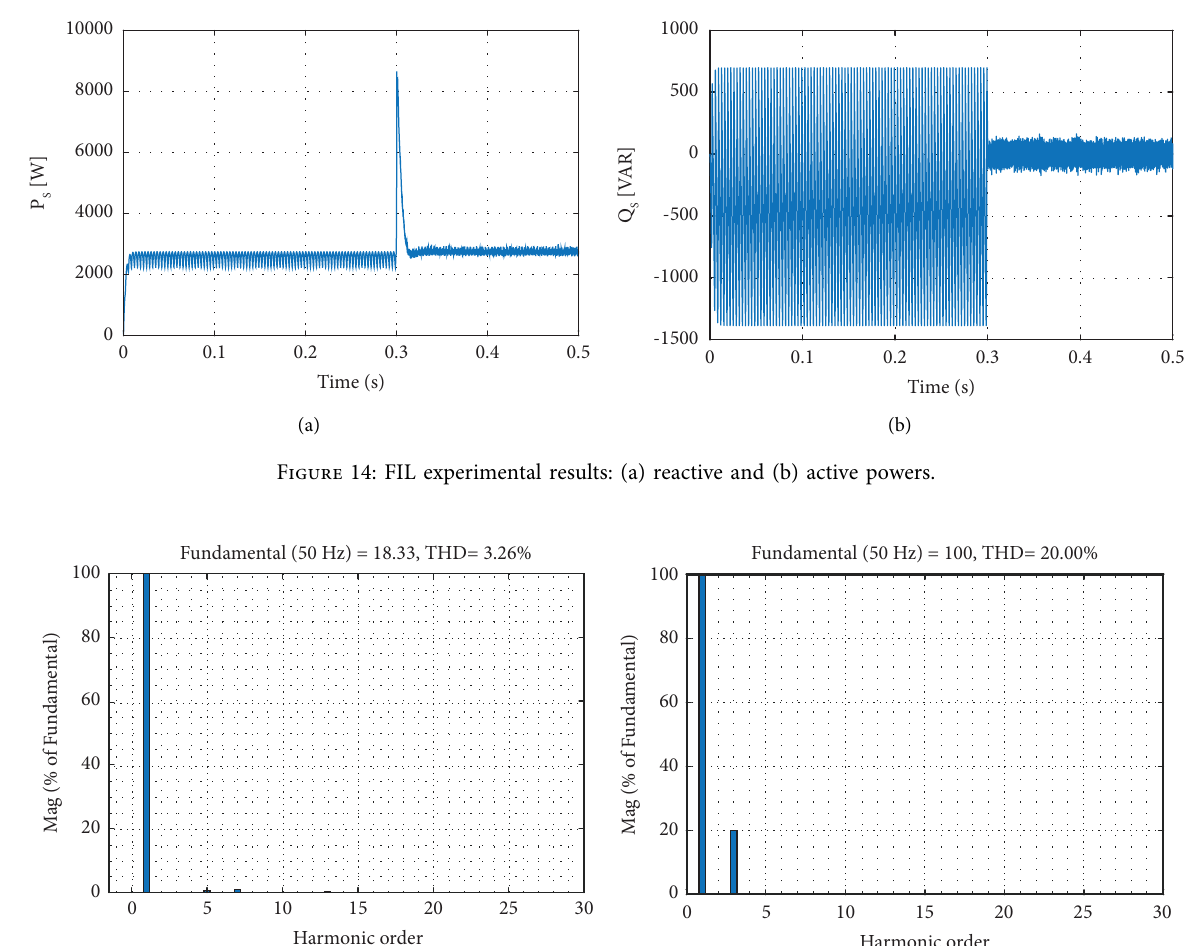
Fundamental (50 Hz) = 18.55, THD= 84.64%